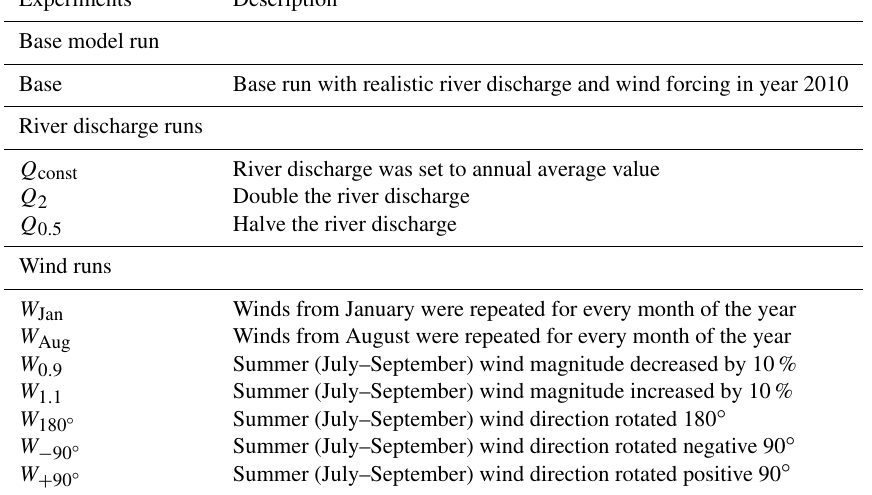
Table 1. Model sensitivity